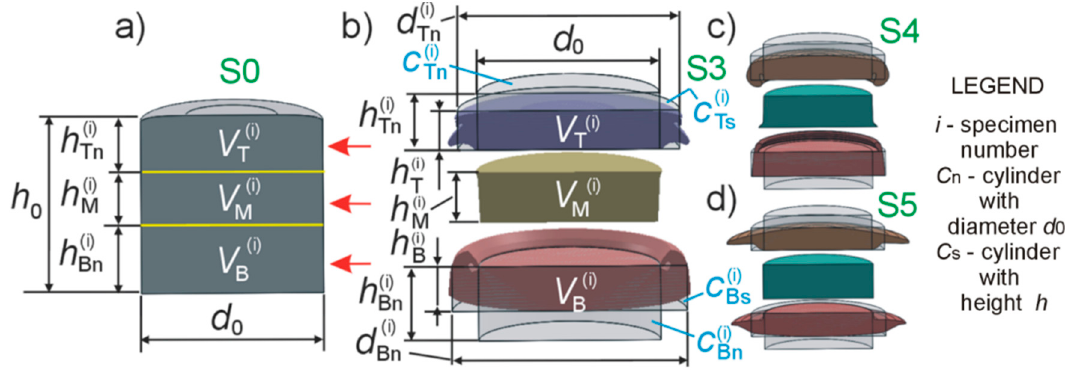
Figure 7. The methodology for determining the average equivalent strain. Figure 7. ( a )–( d ) The methodology for determining the average equivalent strain.